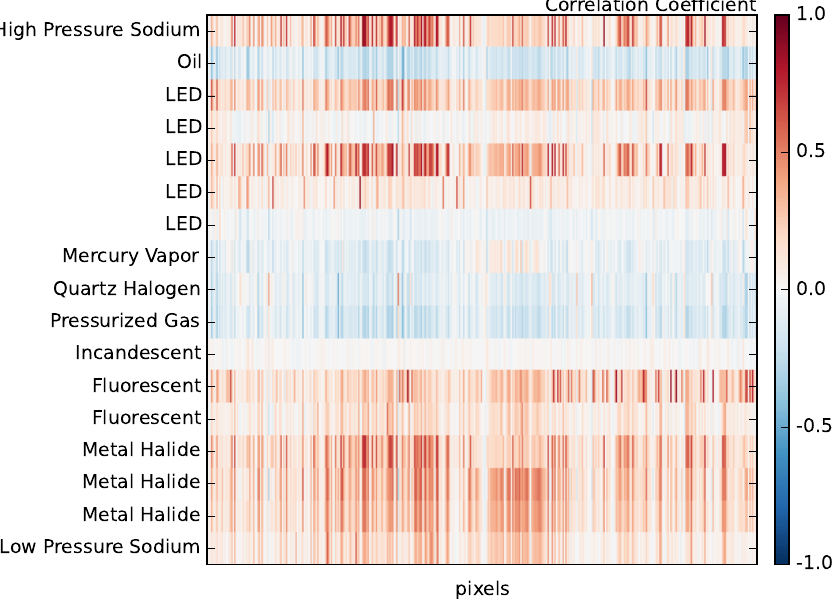
Figure 13. The correlation coefficients for all 41,583 spectra in our dataset with each of the NOAA templates in Figure 9. We clearly detect examples of 13 of the templates with high correlation coefficients. Interestingly, we do not find examples of incandescent light bulbs (see Section